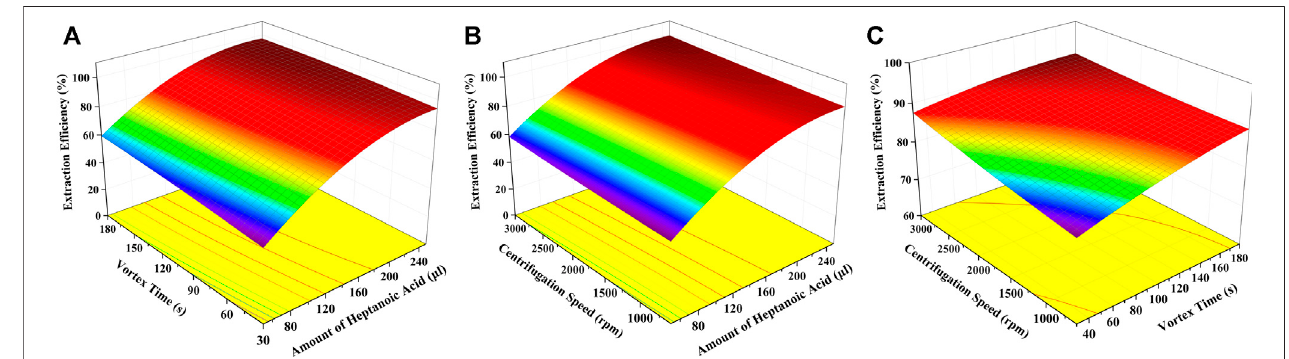
FIGURE 7 | Response surface plots of different variable combinations: (A) amount of heptanoic acid and vortex time, (B) amount of heptanoic acid and centrifugation speed, and (C) vortex time and centrifugation speed.